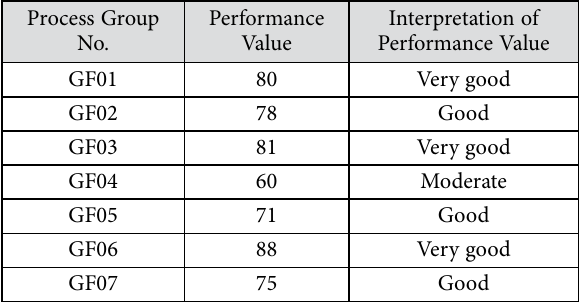
Table 9. Evaluation outputs for process group Process Group